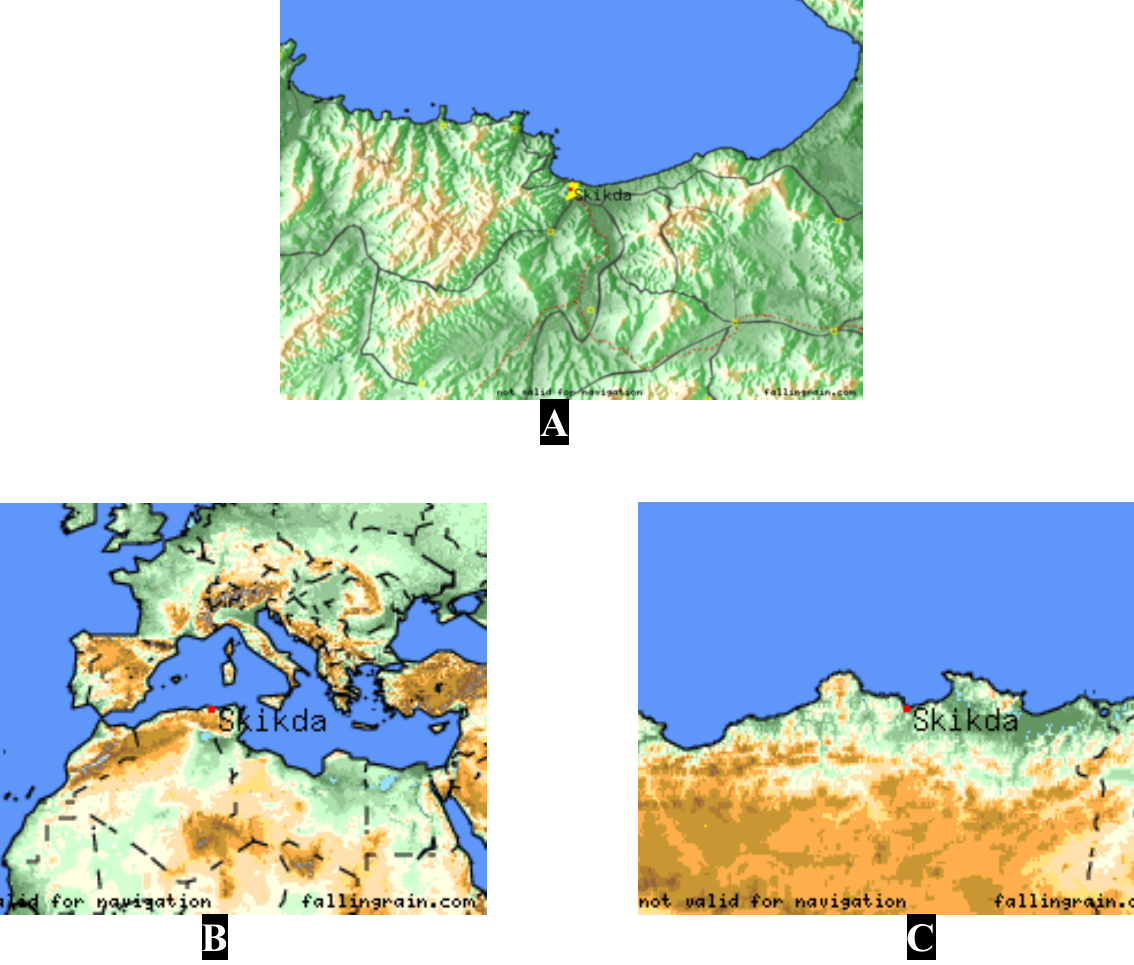
Figure 1: The study area (A-C): Skikda bay area with different zooming.